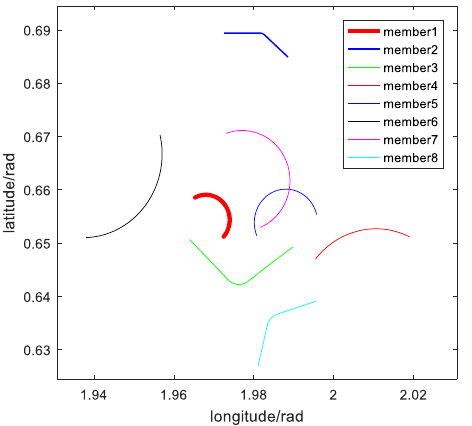
Figure 8. Horizontal vehicle trajectories of network members.